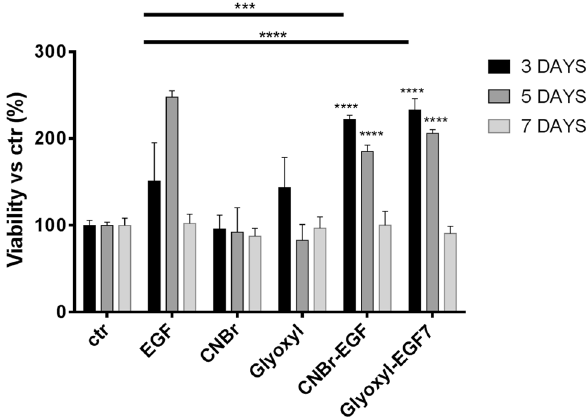
Figure 8. Effect of soluble EGF and immobilized EGF (CNBr-EGF and Glyoxyl-EGF7) on viability of NHDF. Untreated cells (ctr), CNBr-activated-agarose (CNBr) and glyoxyl-agarose (Glyoxyl) carriers were used as controls. Cells were treated for 3, 5 and 7 days with 50 ng/mL of EGF in the soluble form and as immobilized EGF, at day 5 the treatment has been removed and media replaced with fresh complete medium. After an additional incubation for 3 h with 5 mg/mL MTT reagent, the formation of formazan was determined at 540 nm in a photometer plate reader. Data were normalized to average cell viability of CTR (cells w/o treatment). Each measurement was made in triplicate, and data represented the means ± SD. A probability value less than 0.05 (*p < 0.05) was defined to be significant and 0.01 (**p < 0.01), 0.001 (***p < 0.001), 0.0001 (****p < 0.0001) as highly significant by Tukey’s multiple comparison